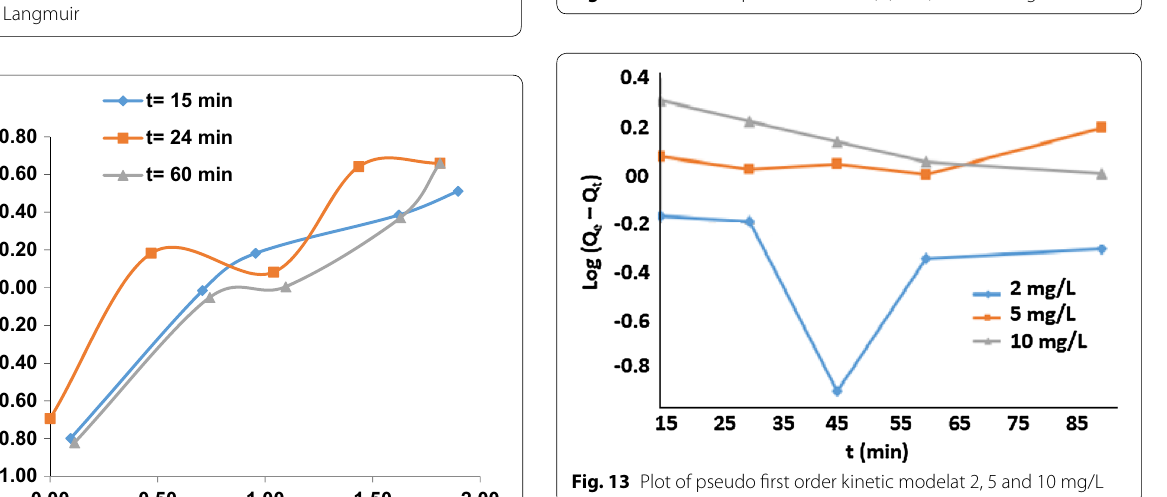
Fig. 12 kinetic adsorption of Arsenic (III) at 2, 5 and 10 mg/L